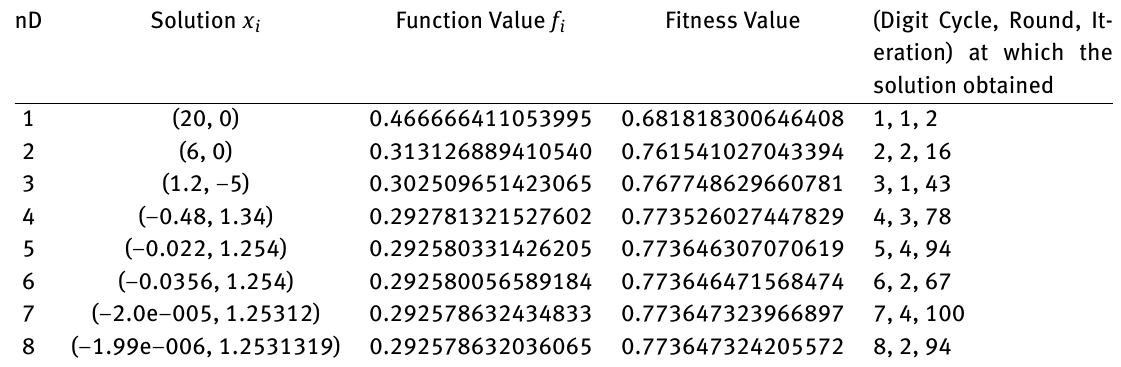
Table 30: Digit Cycle Results for Schaffer 4 function’s with 2 variables nD